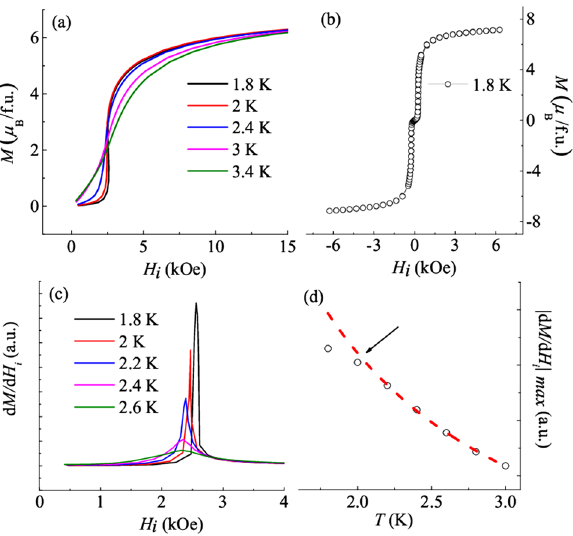
Figure 2. ( a ) M ( H i ) curves up to 15 kOe at various temperatures in the AFM ordered state. ( b ) M ( H i ) curve at 1.8 K up to 70 kOe. ( c ) d M/ d H i at different temperatures in the AFM ordered state plotted as a function of internal field. ( d ) Temperature dependence of the maximum value in differential susceptibility, |d M /d H i | max , plotted as a function of temperature. Red dashed line represents the power-law fitting of the form T −n . The black arrow denotes the deviation from power-law at low